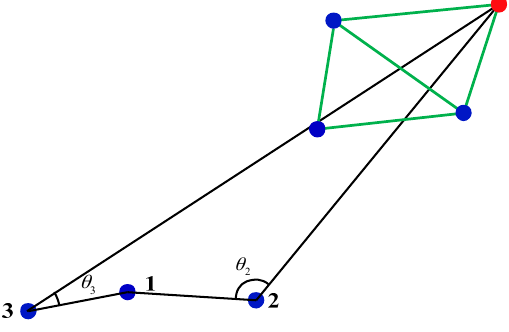
Figure 8. Schematic diagram of the node connectivity angle.